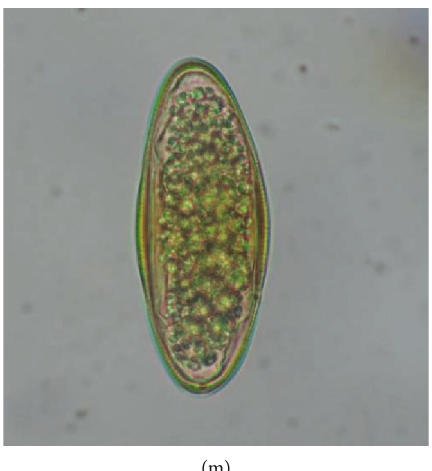
Figure 3: Photomicrographs of various parasitic species. (a) Oocyst of Eimeria sp. (i) ( 20 × 14 μ m), 400x, direct wet mount at Gram ’ s iodine stain, in insectivorous bat. (b) Oocyst of Eimeria sp. (ii) ( 17 × 15 μ m), 400x, after fl otation technique at Giemsa ’ s stain, in insectivorous bat. (c) Cyst of Entamoeba sp. ( 11 × 11 μ m), 400x, direct wet mount at Lugol ’ s Iodine stain, in insectivorous bat. (d) Oocyst of Isospora sp. ( 25 × 23 μ m), 400x, after fl otation technique, in insectivorous bat. (e) Egg of Ascarid sp. ( 54 × 36 μ m), 400x, after sedimentation technique at Giemsa ’ s stain, in insectivorous bat. (f) Egg of Toxocara sp. ( 50 × 49 μ m), 400x, direct wet mount at 2.5% potassium dichromate, in insectivorous bat. (g) Light purple-colored egg of Hymenolepis sp. ( 52 × 43 μ m), 400x, after fl otation technique, in insectivorous bat. (h) Egg of Hymenolepis sp. ( 44 × 43 μ m), 400x, after fl otation technique, in frugivorous bat. (i) Brown-colored egg of Hymenolepis sp. ( 65 × 62 μ m), 400x, after fl otation technique in insectivorous bat. (j) Egg of Strongyloides sp. ( 87 × 46 μ m), 400x, after sedimentation technique at Gram ’ s iodine stain, in insectivorous bat. (k) Egg of Strongyle ( 83 × 41 μ m), 400x, after fl otation technique, in insectivorous bat. (l) Egg of Capillarid sp. ( 67 × 25 μ m), 400x, direct wet mount at 2.5% potassium dichromate, in insectivorous bat. (m) Egg of Oxyurid sp. ( 93 × 36 μ m), 400x, after fl otation technique, in insectivorous bat.